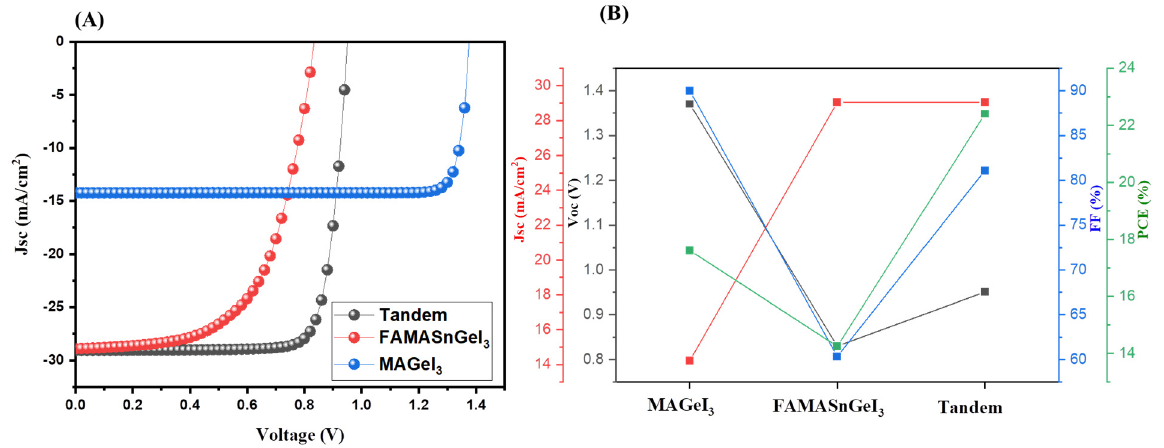
Figure 4. J–V curves ( A ) and photovoltaic parameters ( B ) of MAGeI 3 , FAMASnGeI 3 , and tandem PSCs using ZnSe as the ETL. PSCs using ZnSe as the